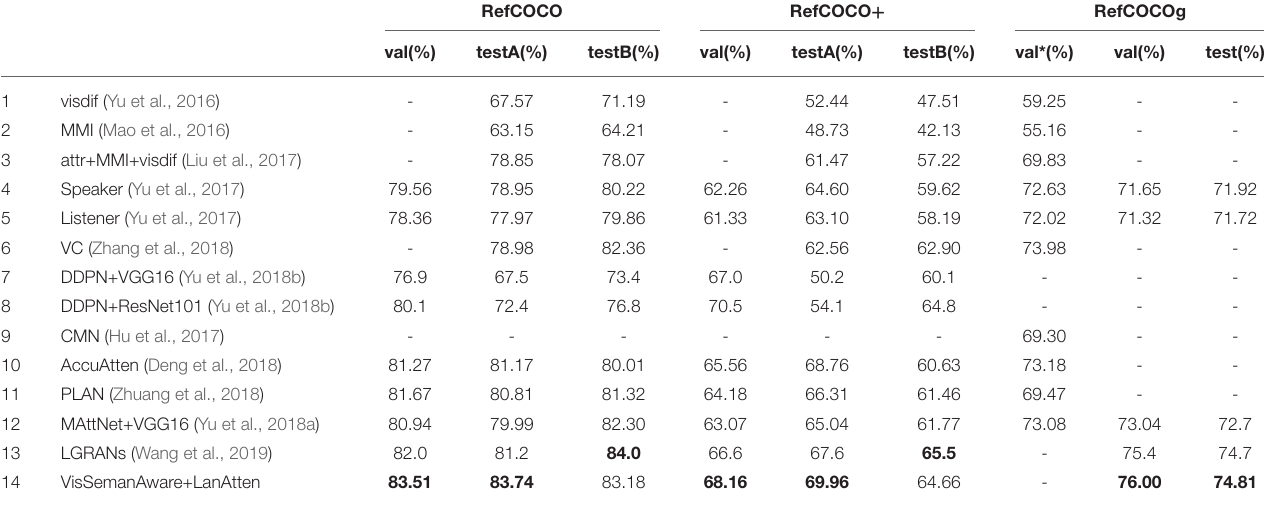
The bold values show the best grounding accuracy on each dataset